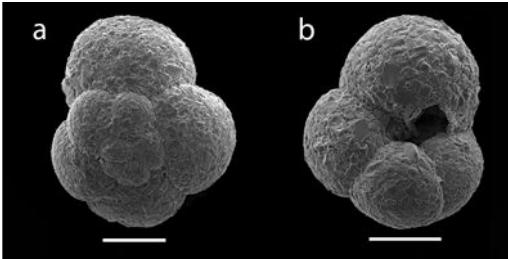
Figure 2. Ammoglobigerina globigeriniformis (Parker & Jones, 1865). (a) Dorsal view; (b) ventral view. Scale bar: 100